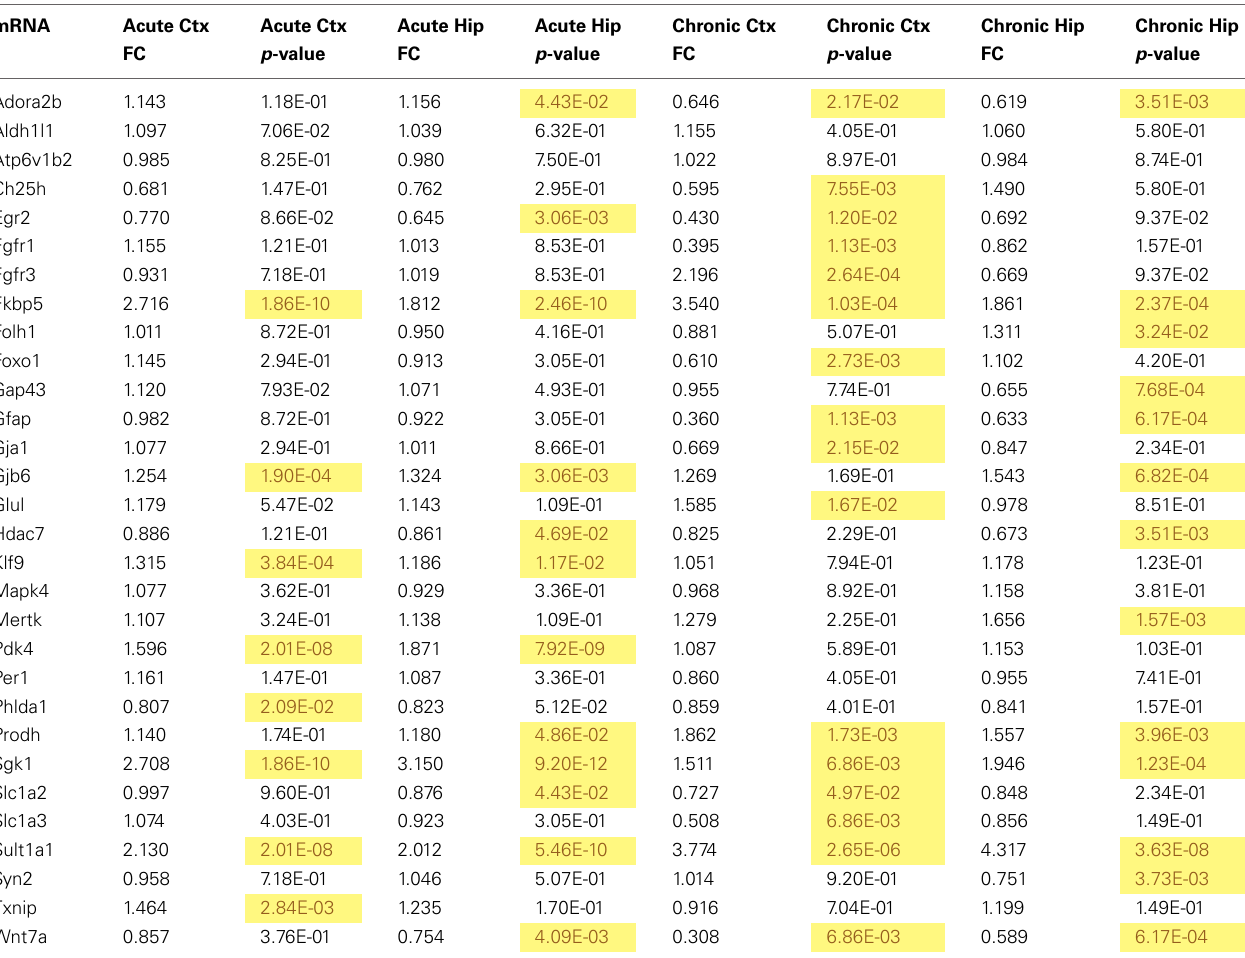
Table 3 | qPCR data for all mRNAs measured for mRNA regulation by acute and chronic corticosterone exposure in the brain in vivo.